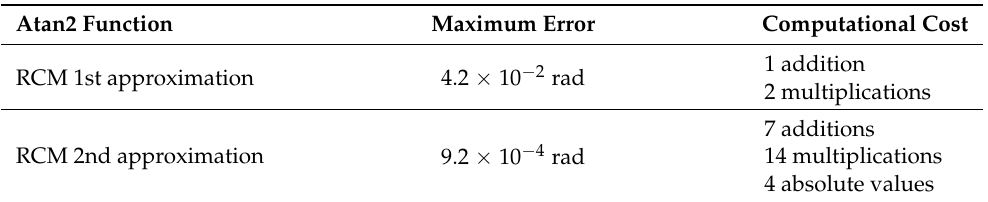
Table 4. Error and computational cost of inverse trigonometric functions. Atan2 Function Maximum Error Computational Cost RCM 1st